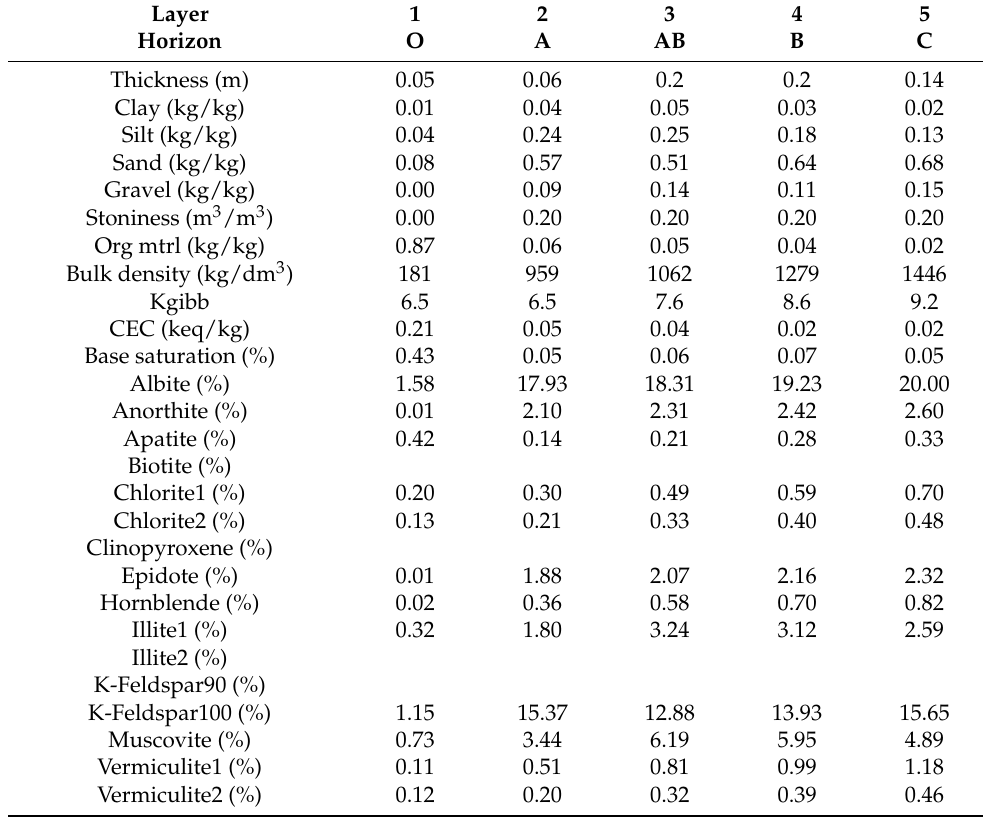
Table A5. Soil parameters for the Southern